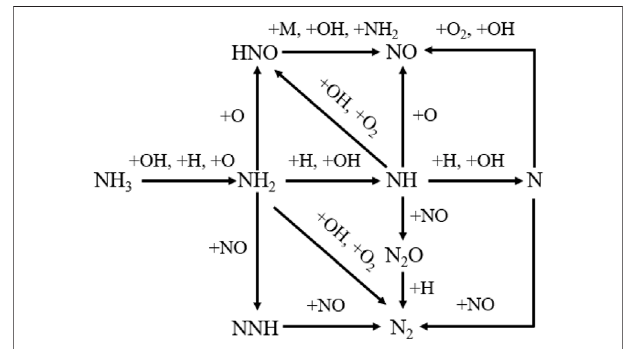
FIGURE 9 | Diagram of ammonia oxidation pathway, replotted from (Millar and Bowman, 1989).